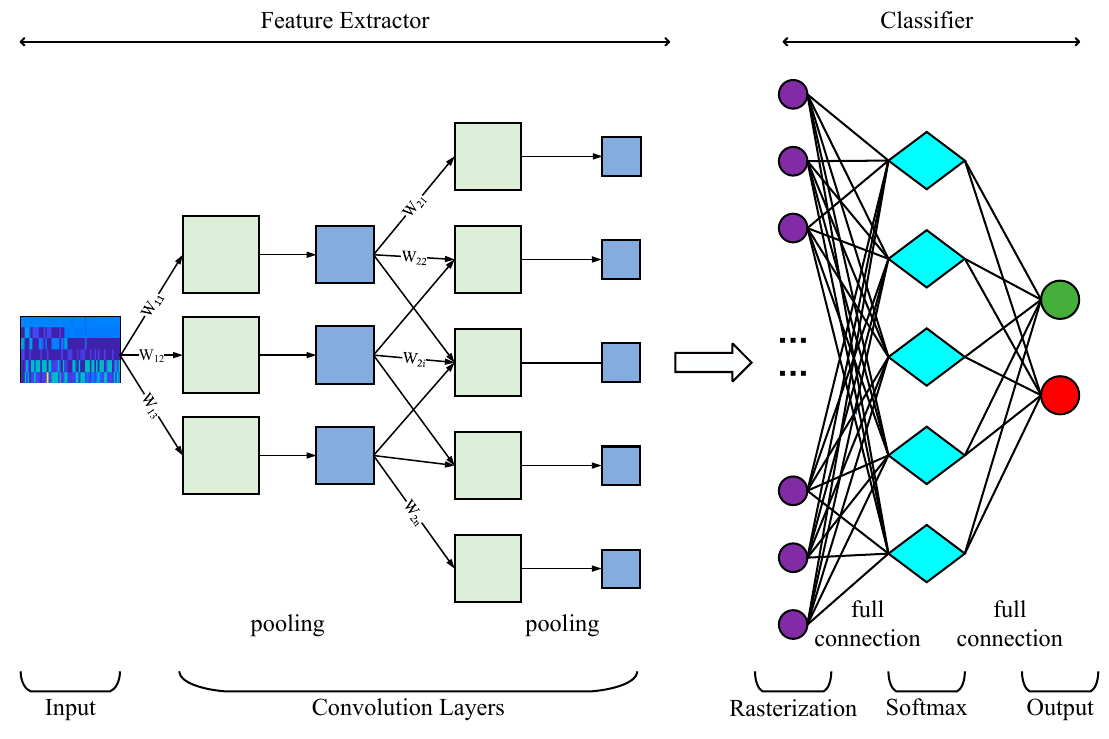
Figure 5. Fusion process of dual-view feature image.